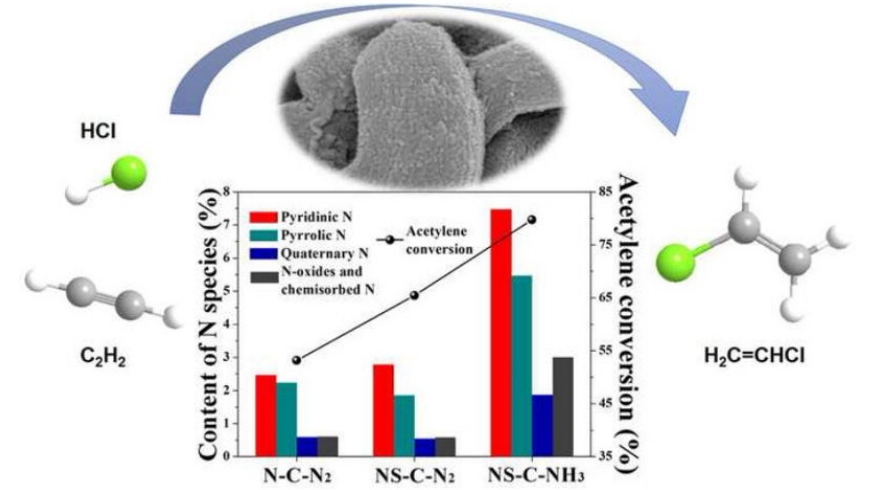
Figure 20. S and N co-doped carbon catalyst for acetylene hydrochlorination [120].